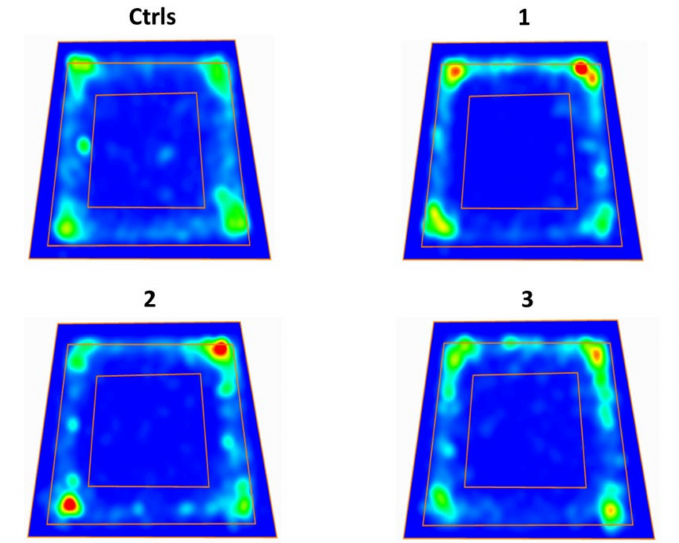
Figure 6. Heat maps showing the mean time spent by each treatment group in the central and peripheral zones of the test arena, where the red color indicates the maximum time of occupancy in either zone (=30 s). Ctrls = control sham-operated rats; 1 = sTBI only, sacrificed at 7 days post-injury; 2 = sTBI + 1 mg/kg b.w. ILB ® , sacrificed at 7 days post-injury; 3 = sTBI + 5 mg/kg b.w. ILB ® , sacrificed at 7 days post-injury.